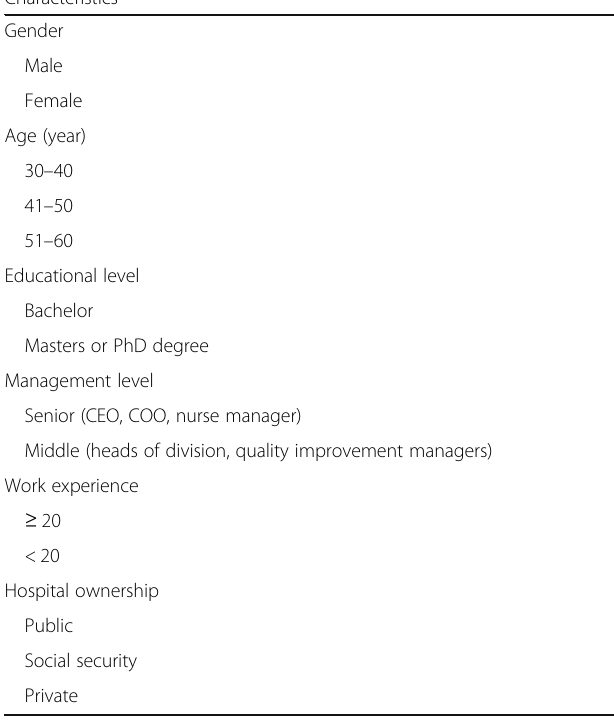
Table 1 Demographic characteristics of managers, Iran hospitals, 2017